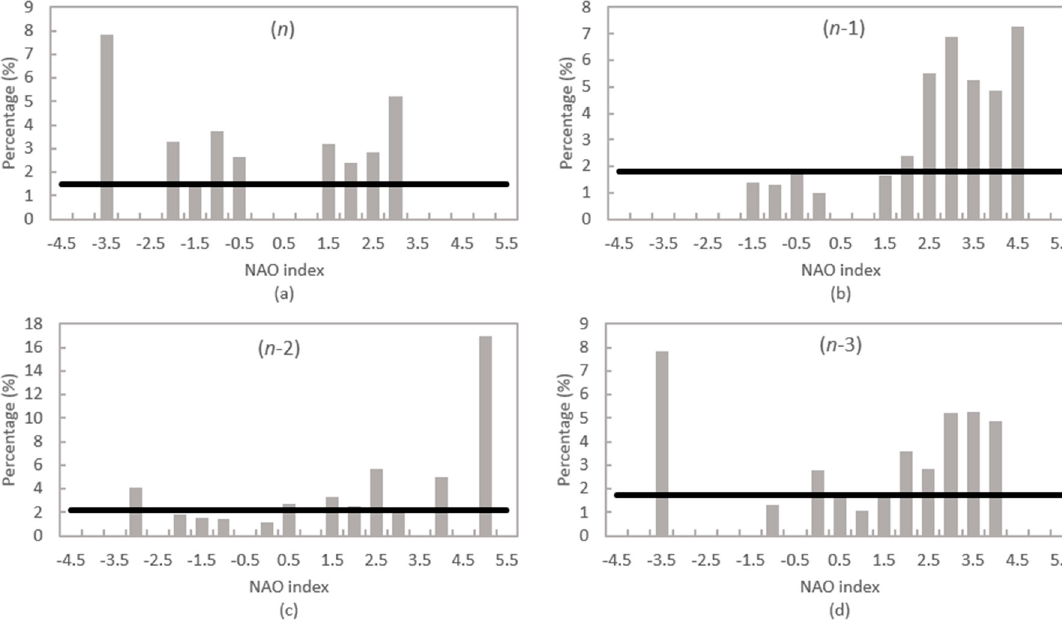
Figure 5. All plots show the percentage of pro-pluvia rogations celebrated in spring associated to the NAO index in months n ( a ), n -1 ( b ), n -2 ( c ) and n -3 ( d ). All black lines are the distribution of the null hypothesis for each case.